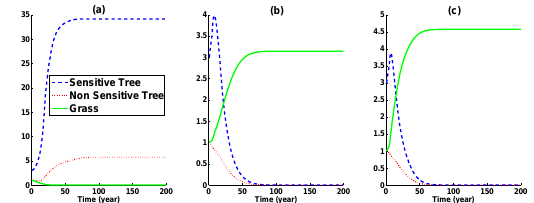
Fig. 5. From forest to grassland as a function of the fire period τ . From left to right, the fire period τ increased, while the sensitive tree-grass competition parameter σ G is fixed. In (a) ( τ = 0 . 3 , σ G = 0 . 05), in (b) ( τ = 0 . 4 , σ G = 0 . 05) and in (c) ( τ = 0 . 5 , σ G = 0 .